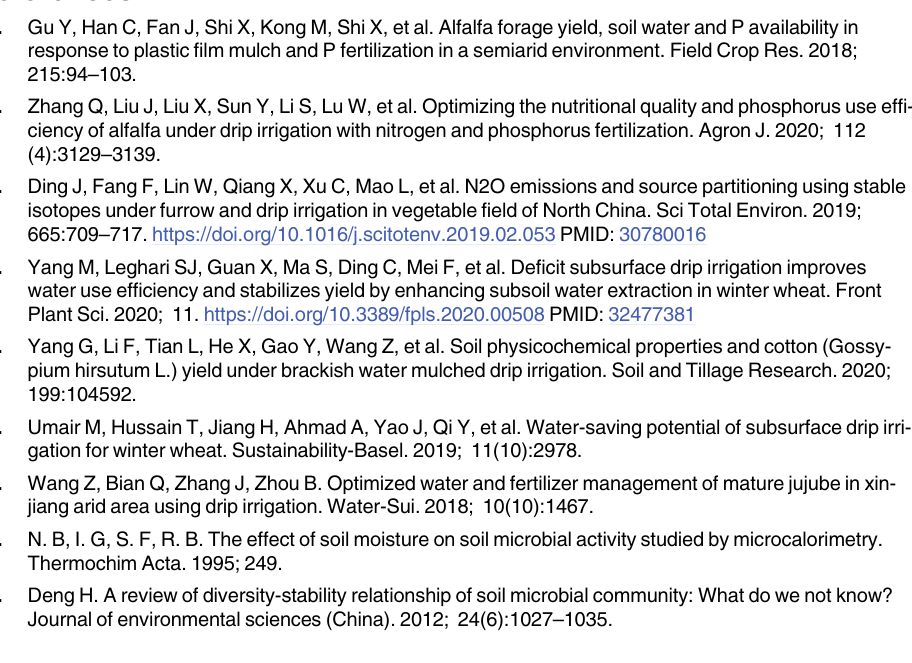
S1 Fig. Comparison of dominant fungal